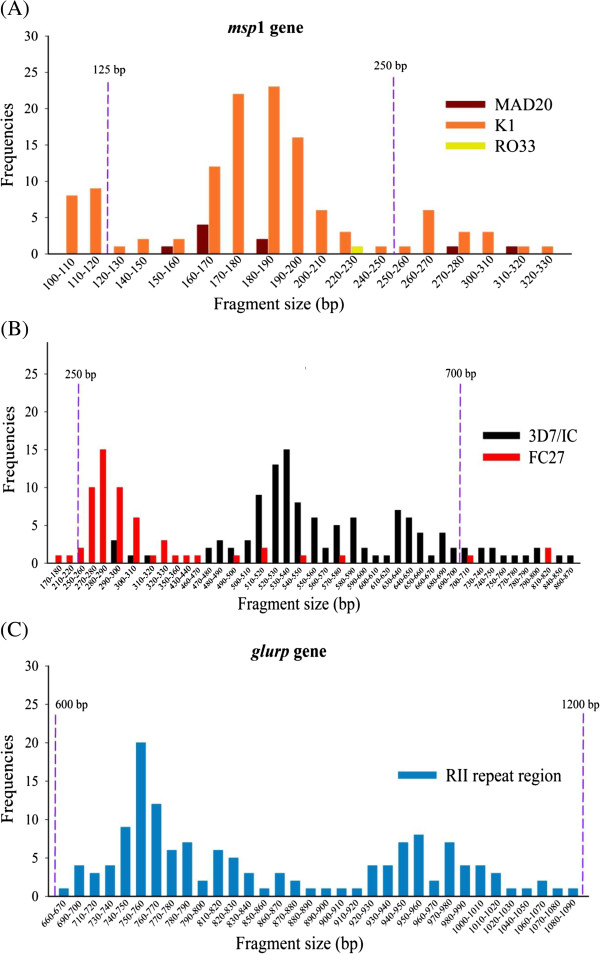
Parasite genetic diversity detected by msp1, msp2 and glurp. Polymerase chain reaction (PCR) products were categorized into molecular weight groups differing by 10 bp. (A)msp1. Orange bars represent K1; brown bars, MAD-20; and yellow bars, RO33 allelic families. The 18 K1 alleles ranged in size from 100 to 330 bp; the 5 MAD-20 alleles; 150 to 320 bp; and the 1 RO33 alleles, 220-230 bp. (B)msp2. Red bars represent FC27 and black bars represent IC3D7 allelic families. The 18 FC27 alleles ranged in size from 170 to 820 bp, and the 33 IC3D7 alleles ranged in size from 290 to 870 bp. (C)glurp. The glurp alleles ranged in size from 660 to 1,090 bp. Dashed purple lines represent fragment size thresholds for each gene [10].